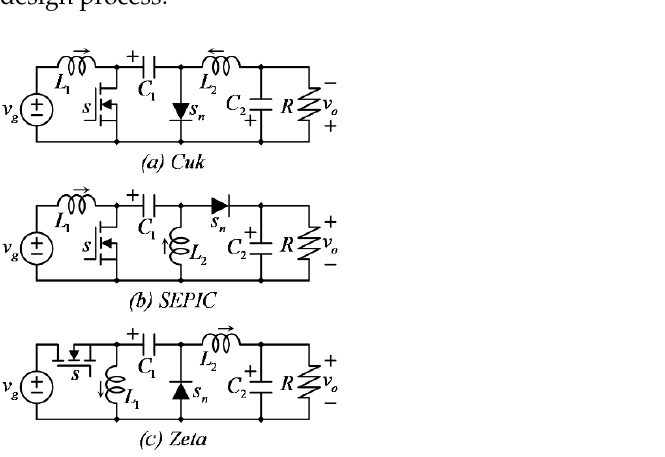
Figure 2. Fourth order (FO) converters: ( a ) Cuk, ( b ) SEPIC, and ( c ) Zeta converters.